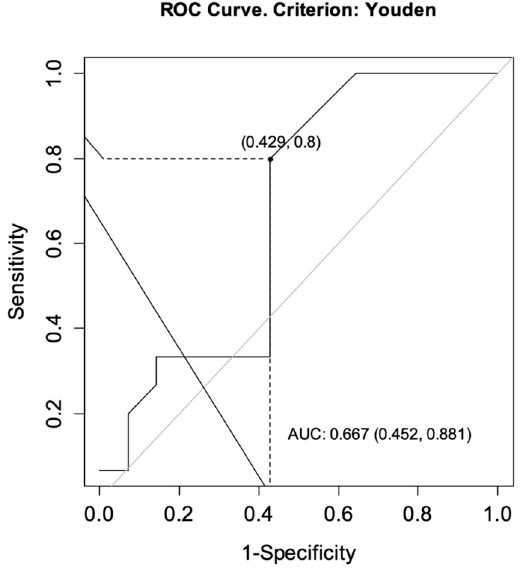
Figure 3. ROC curve for infliximab levels as a predictor of achieving a primary response while ensuring no secondary loss of response in patients with ulcerative colitis. AUC, area under the curve.